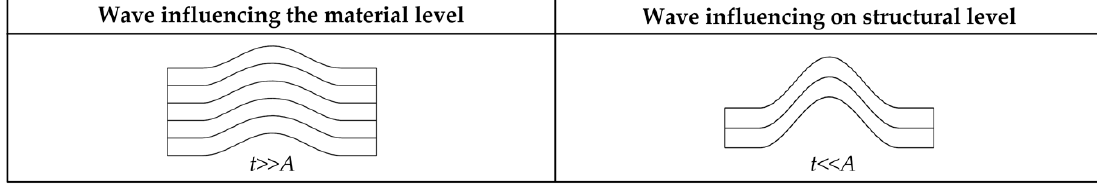
Figure 36. Material vs. structural level.